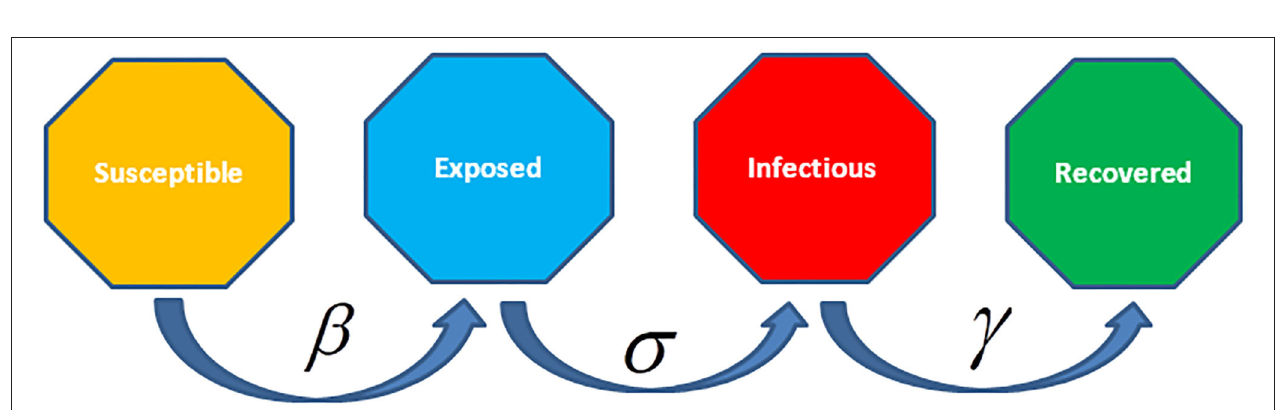
FIGURE 9 | The Susceptible-Infected-Recovered- Susceptible (SIRS) model is an epidemiological model that describes the theoretically infected individuals with a contagious infection in a closed population over time. In this model, the equations are related to the susceptible, infected, and recovered number of individuals along with re-susceptible individuals for the disease.